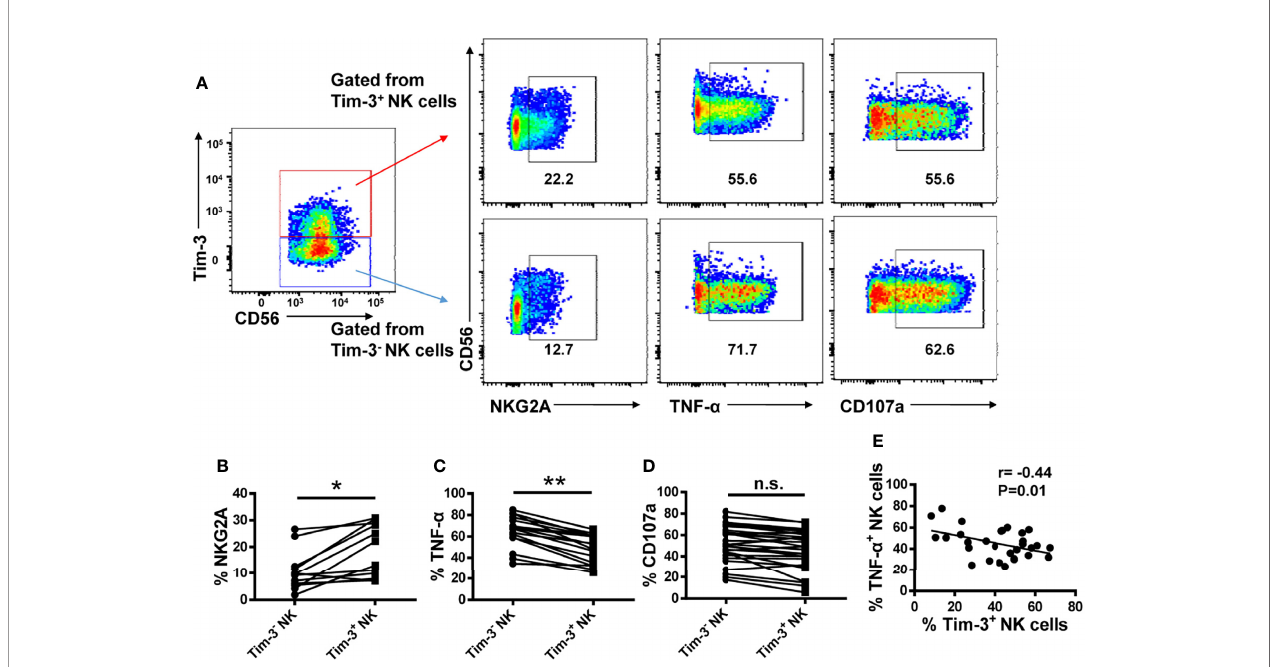
FIGURE 6 | Tim-3 + NK cells display weaker activities than Tim-3 − NK cells in patients with T2DM. (A) Representative fl ow cytometry plots of NKG2A, TNF- a and CD107a and expression on Tim-3 + and Tim-3 − NK cells. (B – D) Proportions of NKG2A + (B) , TNF- a + (C) , and CD107a + (D) Tim-3 + and Tim-3 − NK cells. (E) Analysis of the correlation between TNF- a levels and the percentage of Tim-3 + NK cells in patients with T2DM (Spearman ’ s correlation test). *P < 0.05, **P < 0.01, n.s., not signi fi cant.